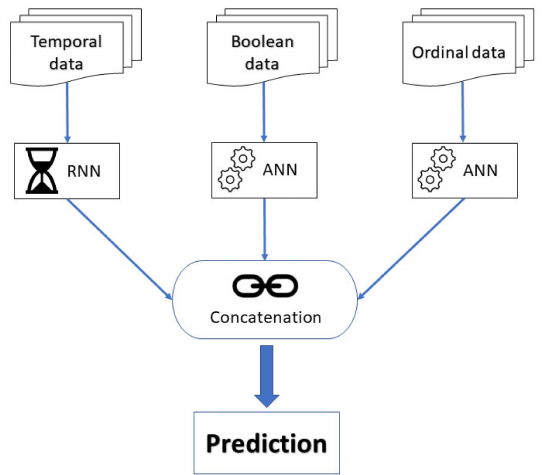
Figure 4. Sketch of the designed multi input neural network. Different types of data are processed by specific layers. Information from data that may have temporal evolution are extracted by a RNN, while other data are passed through dense layers. The last concatenated layer merges the features extracted by all the branches to provide the final